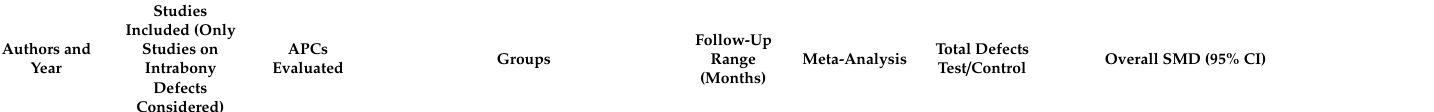
Table 4. Characteristics of the included studies: main